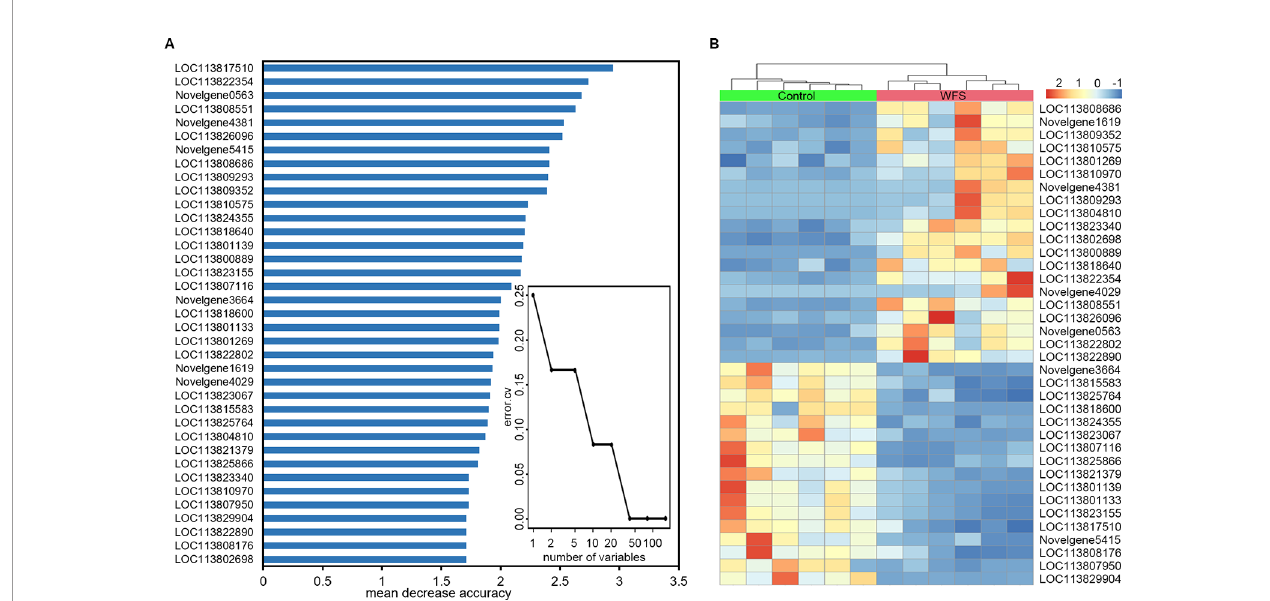
FIGURE 6 | Identi fi cation of predictive biomarkers for white feces syndrome (WFS) by random forests model. (A) The 10-fold cross-validation on a random forests model suggested a total of 37 genes were selected as the optimal markers. The 37-top ranked biomarkers were shown according to the mean decrease accuracy. (B) Heatmap based on the 37 markers revealed that the WFS group was clearly distinct to the Control group.